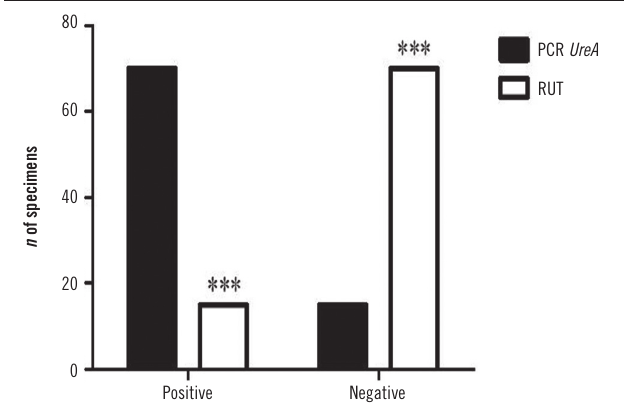
figurE 3 − Comparison between the number of samples and the results obtained by the molecular diagnostic method using the UreA gene and the rapid urease test. There was a significant difference between the groups ( p <